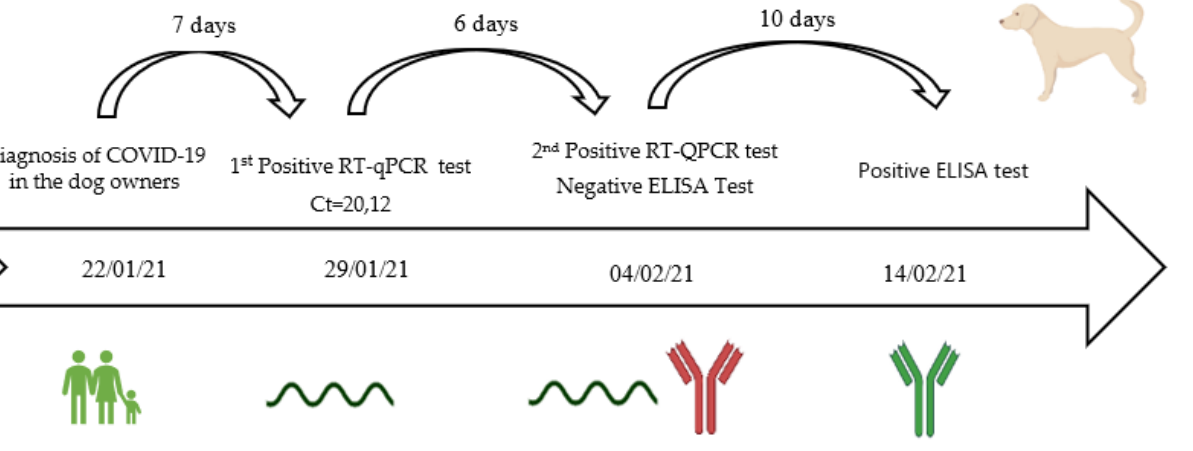
Figure 2. Timeline of the SARS-CoV-2 infection in an asymptomatic dog in a COVID-19-positive household. From the diagnosis of COVID-19 in the dog owners (22 January 2021) to the first and second positive RT-qPCR test of the dog on 29 January 2021 and 4 February 2021, respectively, and the positive ELISA test on 14 February 2021, 16 days after the first positive RT-qPCR test. The green color means positive serological or molecular result and the red color means a negative serological or molecular result. The date corresponds to the day of the blood or swab sampling from the dog.